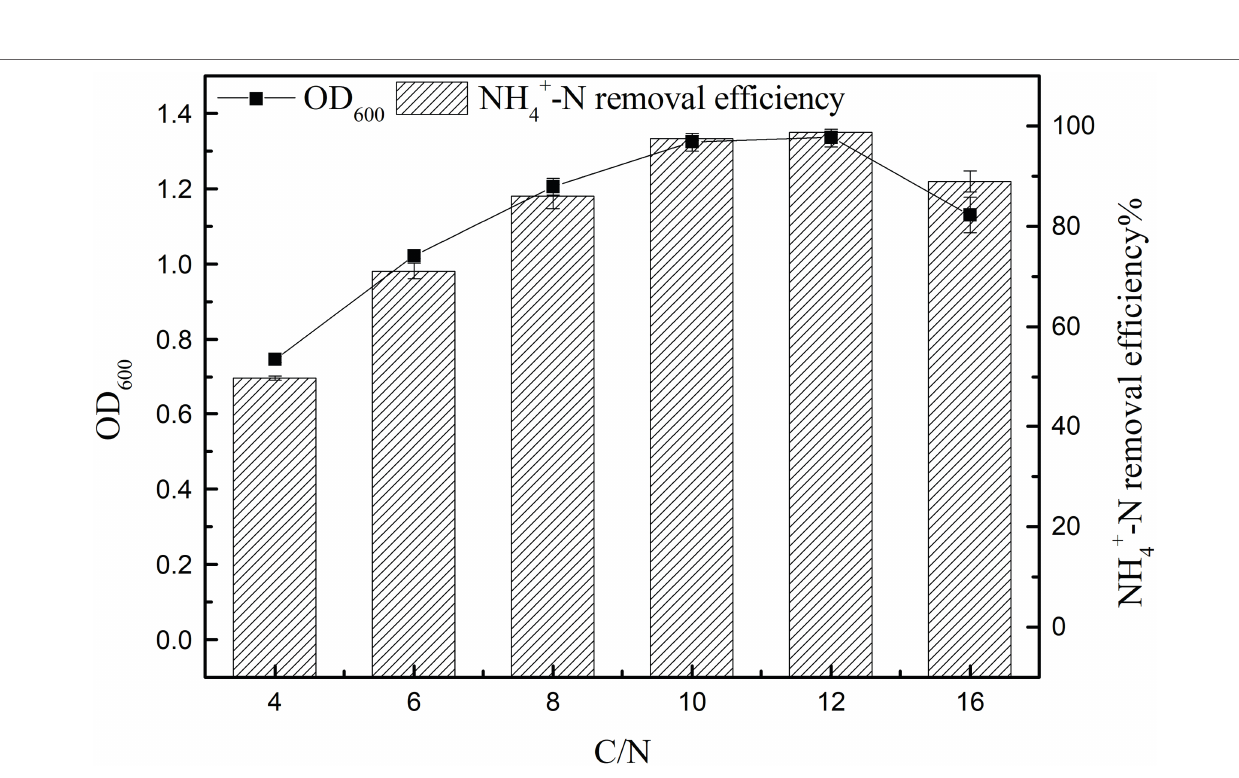
FIGURE 5 | Effect of C/N ratio on the growth and ammonia nitrogen removal efficiency of strain K17. The mixture was cultured at 165 rpm and 30 ° C for 12